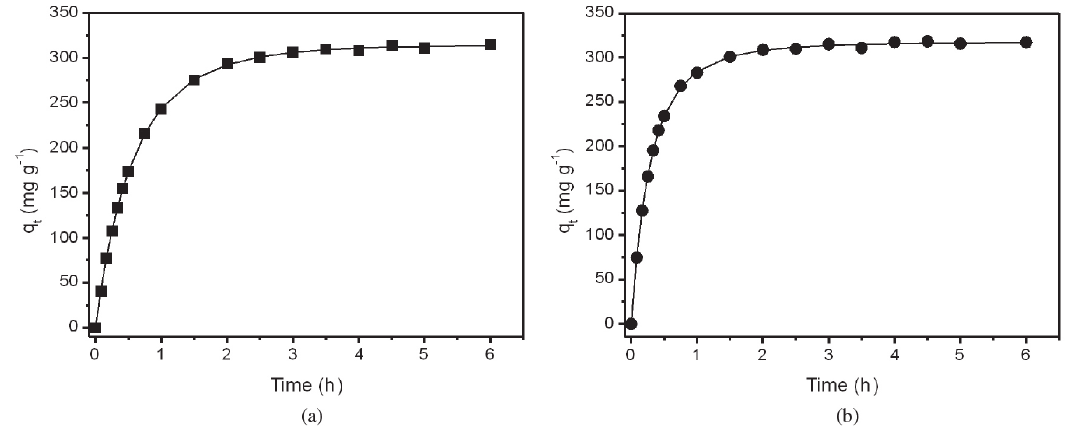
Figure 3. Effect of contact time on the adsorption of RB-4 dye on MWCNT (a) and SWCNT (b). Conditions: C solution; mass of adsorbent of 30.0 mg; the temperature was fixed at 298 K, pH 2.0.